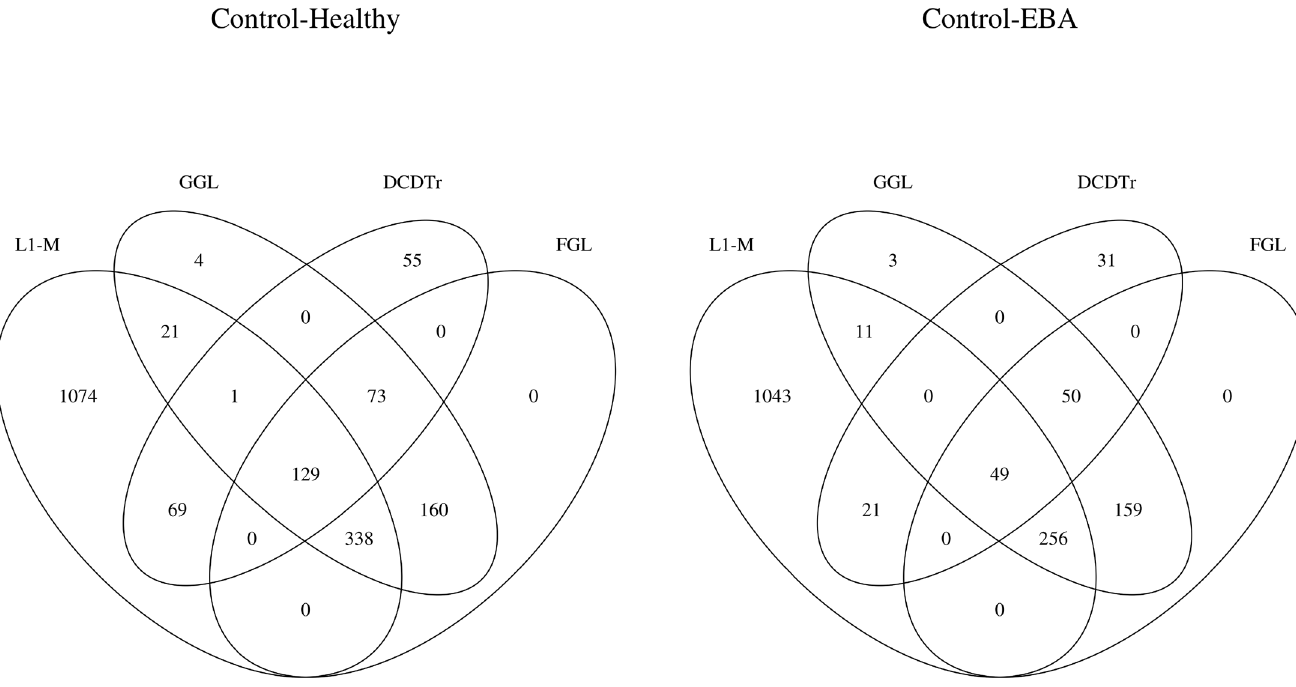
PLOS ONE | https://doi.org/10.1371/journal.pone.0207731 July 24,